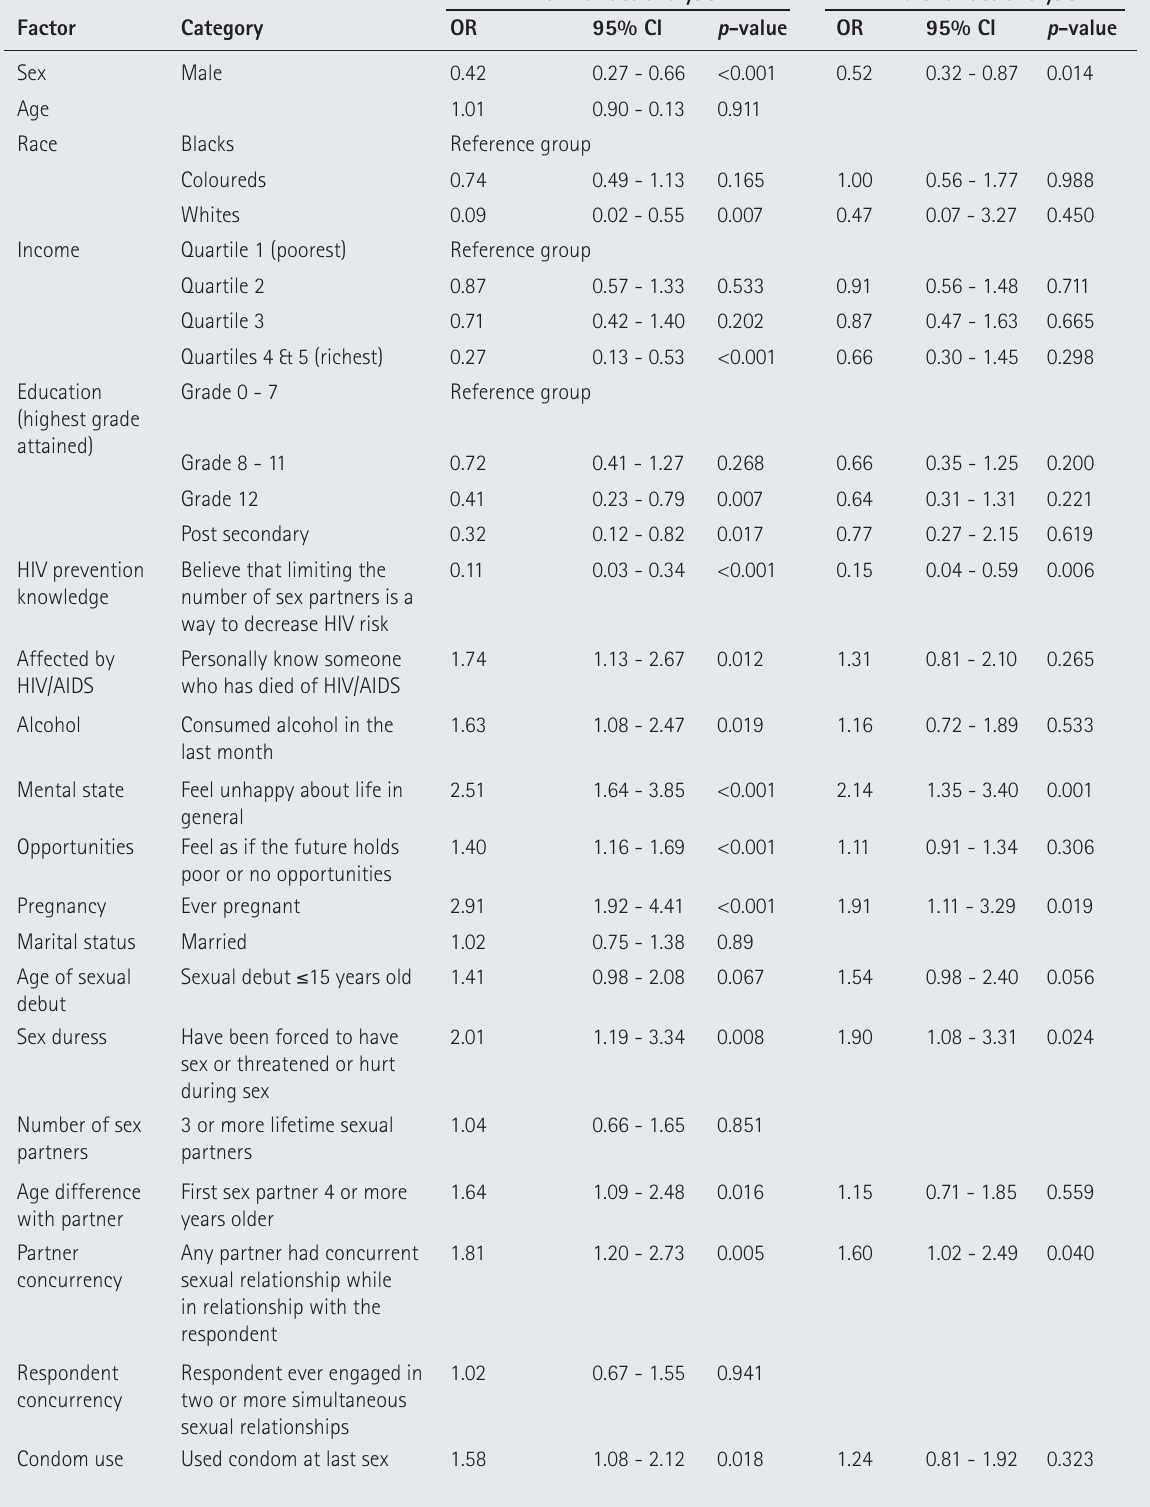
TABLE III. uNIVARIATE AND muLTIVARIATE LOGIsTIC REGREssION mODEL fOR AssOCIATION